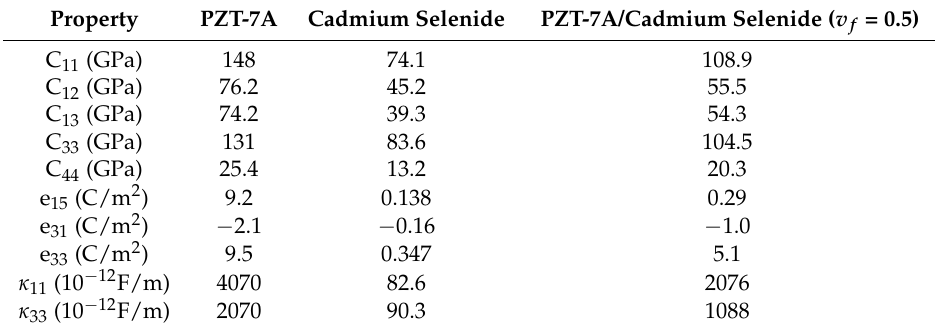
Table 1. Material properties of PZT-7A and cadmium selenide piezoelectric materials: In the 3rd column, the micromechanically predicted effective properties of the PZT-7A/cadmium selenide periodically bilayered composite for which volume fraction is v f = 0.5 are